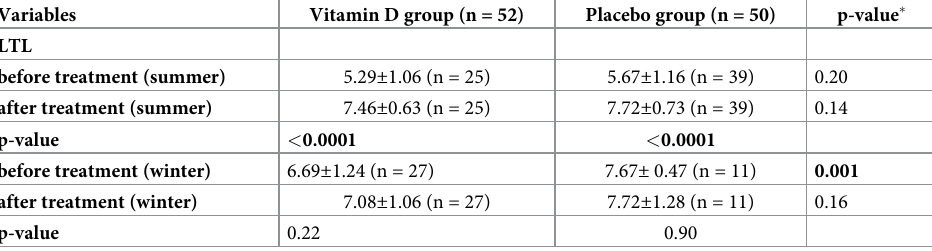
Table 6. Comparison of relative telomere length ( Δ Ct), in treatment and placebo groups according to the season of treatment. Variables